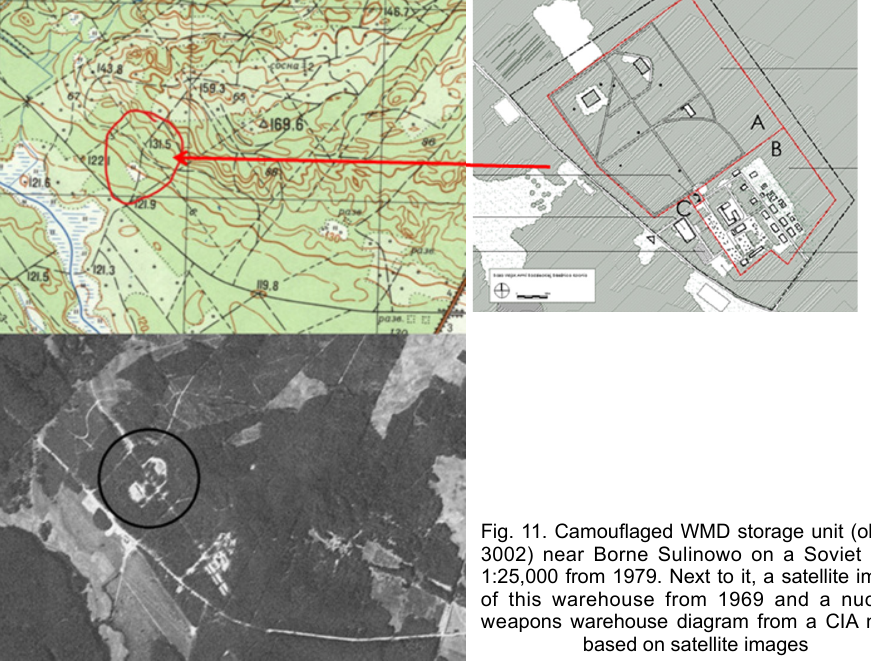
Fig. 11. Camouflaged WMD storage unit (object 3002) near Borne Sulinowo on a Soviet map 1:25,000 from 1979. Next to it, a satellite image of this warehouse from 1969 and a nuclear weapons warehouse diagram from a CIA note, based on satellite